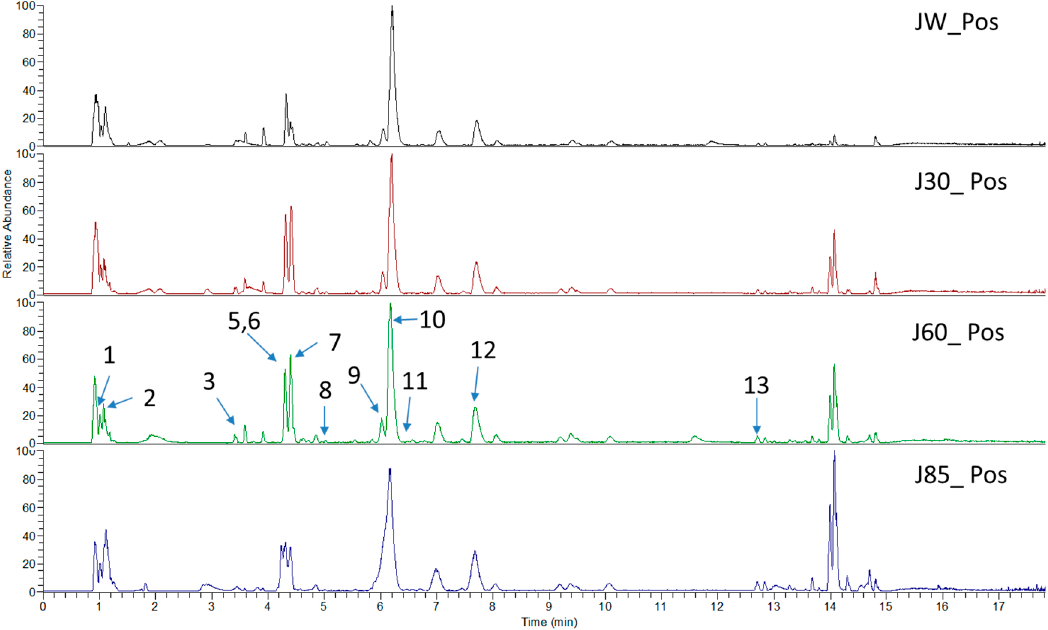
Figure 1. The chemical profile of SG extracts analyzed by UPLC-MS (positive). The numbers indicate the compounds.